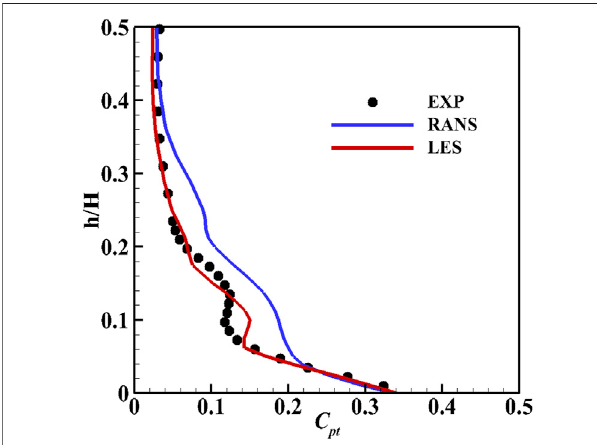
FIGURE 4 | Comparison of C pt distribution along the spanwise.